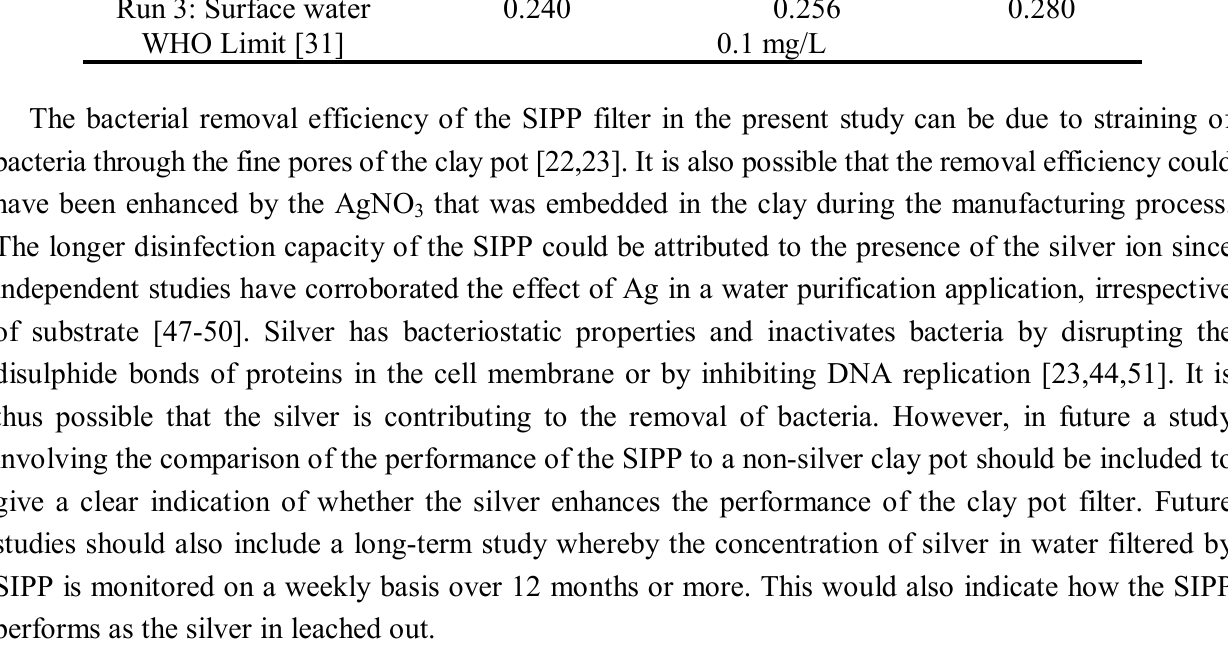
Table 9. Comparing the performance of